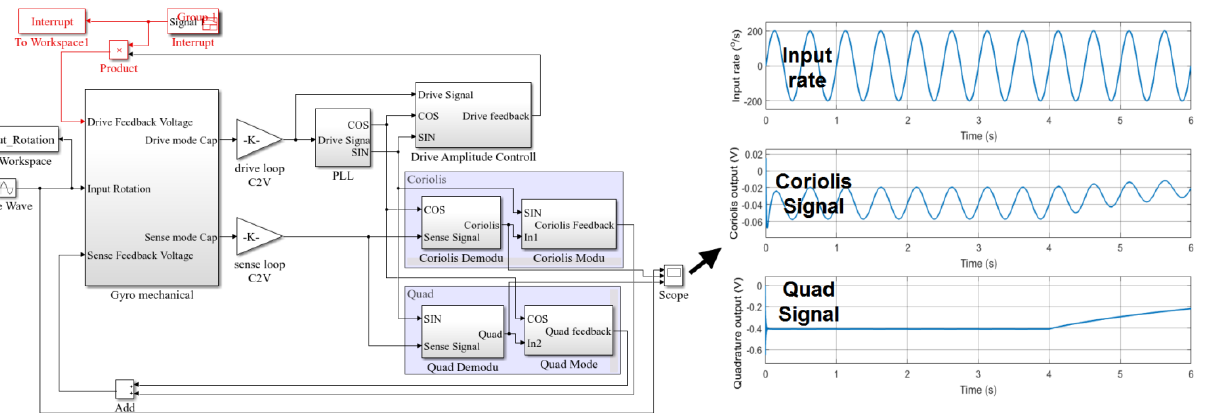
Figure 7. Simulink model for simulating the scenario A malfunction.